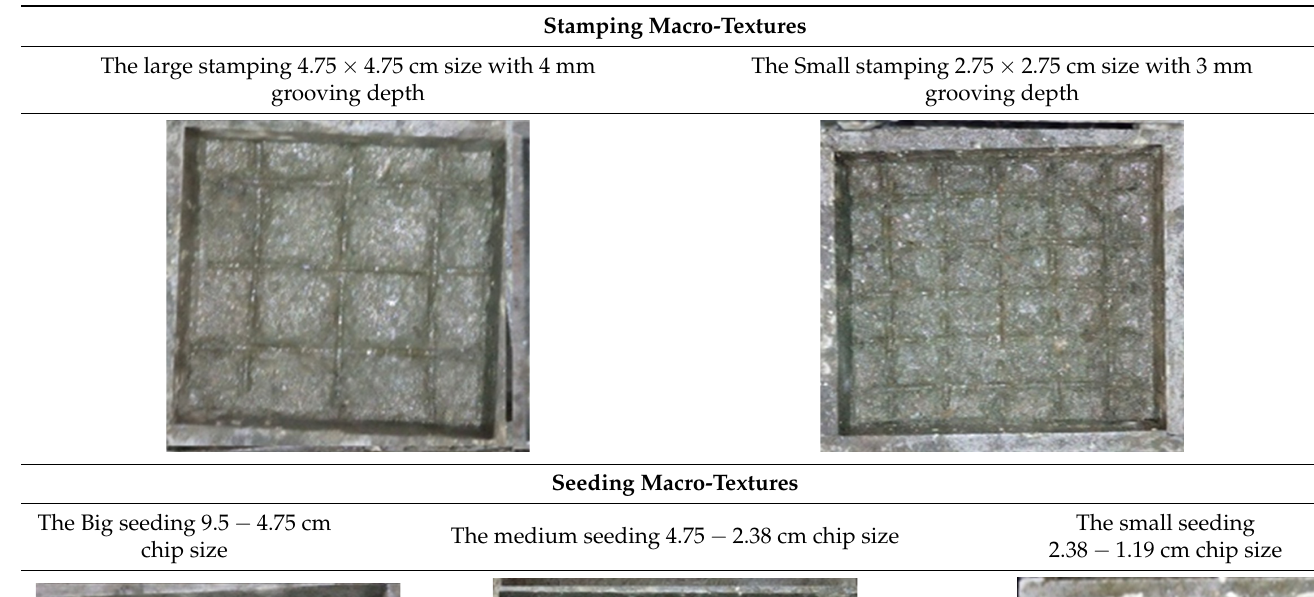
Table 6. Different macro-textures on